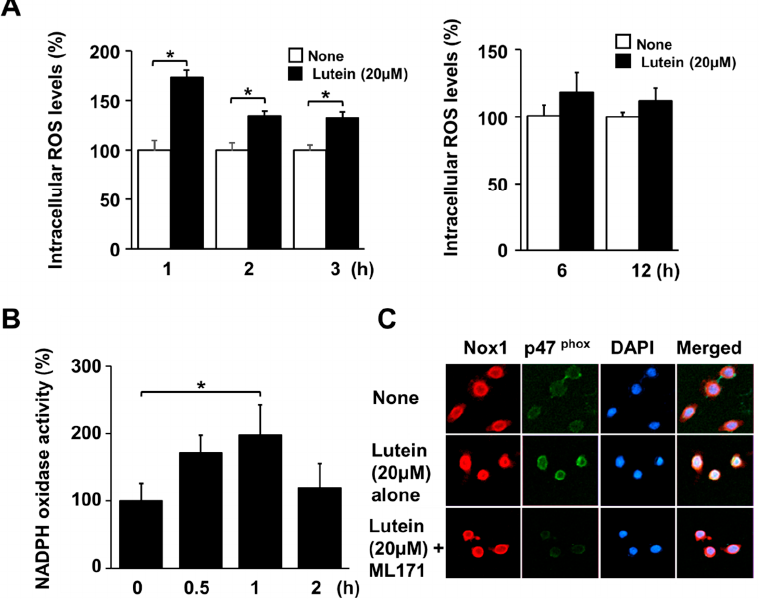
Figure 3. Effects of lutein on intracellular ROS levels, NADPH oxidase activity, and translocation of p47 phox in AGS cells. ( A , B ) Cells were treated with 20 µ M lutein for the indicated time periods. ( A ) Intracellular ROS levels were measured by DCFH-DA assay. The intracellular ROS levels of untreated cells (“none”) were set at 100%. * p < 0.05 ( B ) NADPH oxidase activity in the membrane fraction was measured using lucigenin assay. The NADPH oxidase activity at 0 h was set at 100%. ( C ) The cells were pre-treated with 20 µ M ML171 for 1 h and then treated with 20 µ M lutein for 1 h. Immunocytochemistry of AGS cells was carried out to detect Nox1 and p47 phox . Nox1 and p47 phox were visualized using fluorescein/rhodamine-conjugated anti-rabbit IgG (red) and FITC-conjugated anti-mouse IgG (green) with DAPI counterstaining (blue) of the same field, respectively. 2.4. ML171 and NAC Inhibit Lutein-Induced Increase in ROS and Cell Death in AGS Cells To examine whether the reduction in cell viability was related to the activation of NADPH oxidase and the pro-oxidant properties of lutein, cells were treated with an NADPH oxidase inhibitor (ML171) or an antioxidant NAC before lutein treatment. Pre- treatment with ML171 or NAC suppressed lutein-induced reduction in cell viability (Fig- ure 4A). Similarly, ML171 and NAC prevented lutein-induced DNA fragmentation (Fig- ure 4B). These results suggest that lutein induces cell death via NADPH oxidase-mediated ROS production in AGS cells. As shown in Figure 4C,D, ML171 and NAC inhibited lutein-induced increases in NF- κ B-DNA binding activity and decreases in I κ B α in AGS cells. These results indicate that lutein-induced activation of NF- κ B is mediated by NADPH oxidase and ROS in AGS cells.